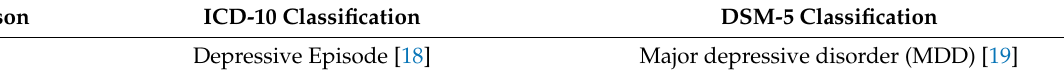
Table 1. Comparison of depression in ICD-10 and DSM-5